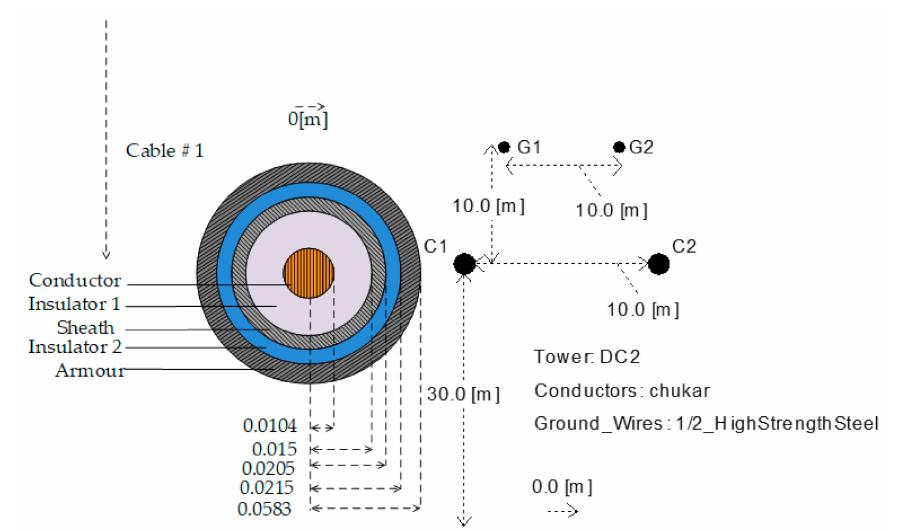
Figure 10. Parameters of cables and overhead lines.